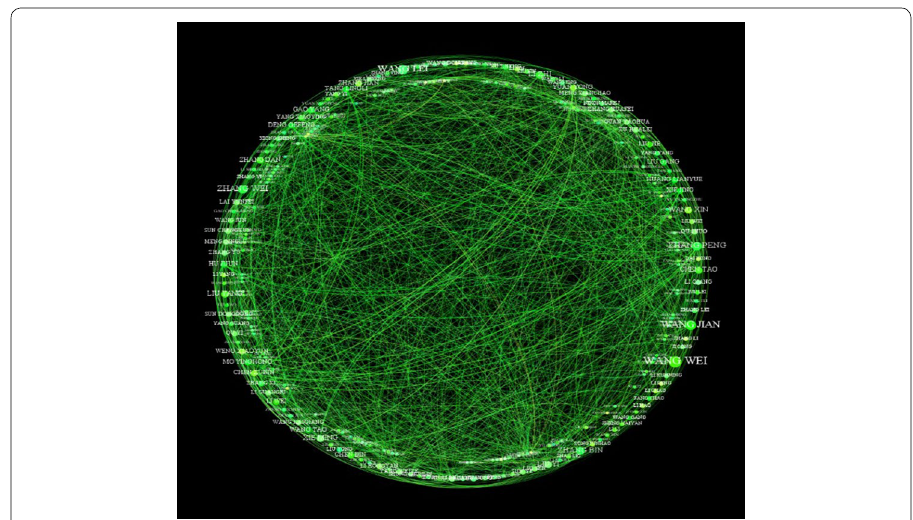
Fig. 11 Network of global